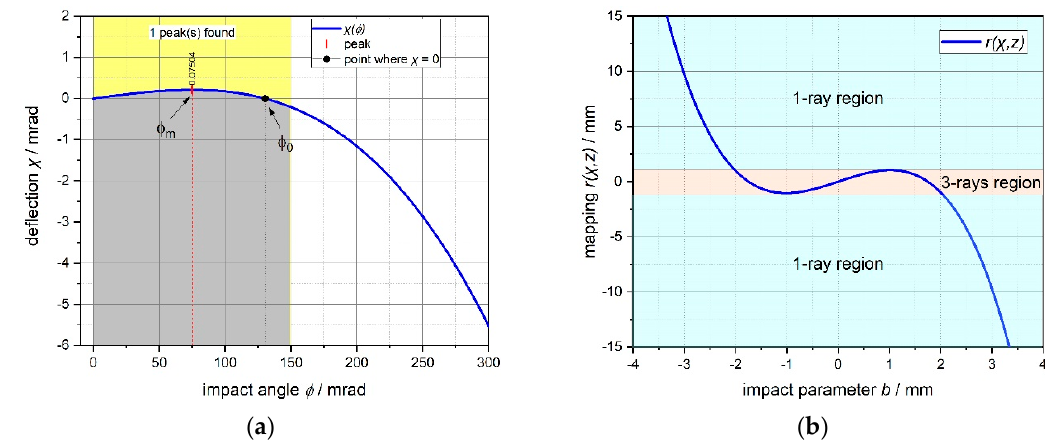
5 of 21 Figure 4. Transfer function for incident and reflected rays of different refractive indices n (the red curve is the most representative for our situation); as soon as a ray moves away from Z axis, increasing its impact parameter b , the deflection angle increases in this way: from a null value, it reaches a maximum in correspondence of 𝜙 (cid:3040) , then it starts decreasing until a null value (parallel to itself but mapped in the other half-space) when 𝜙 = 𝜙 (cid:2868) . Image inspired by [5] (Figure 3). 3.1.1. Ray-Optics on the Sphere at our Disposal In our specific situation (glass used: Ohara S-LAH79, with n = 1.9957745 @ 635 nm, T = 20 °C and P = 1 Atm), numerical analyses with realistic refraction data have been carried on. Adopting the aforementioned nomenclature, the following relations can be derived: • Maximum deflection : χ m = 0.212 mrad when ϕ m = 75.091 mrad, that is when b = b m = 0.599 mm; • Null deflection : χ = 0 when ϕ = ϕ 0 = 130.061 mrad, that is when b = b 0 = 1.037 mm (situation of “perfect” retro-reflection). From Figure 5b it can be argued that, according to the ray-optics, three distinct regions in the codomain of the mapping function r(b, z) exist: the first (“3-rays region”), mapped by the impact